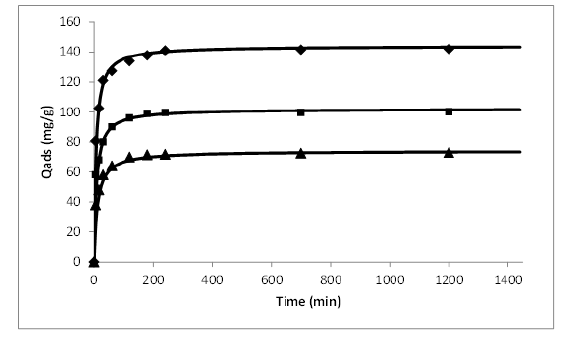
Figure 3. Depedence of zeta-potential on pH values (-) AC(ZnCl (—)AC(H 2 SO 4 ), (....)AC(NaOH)